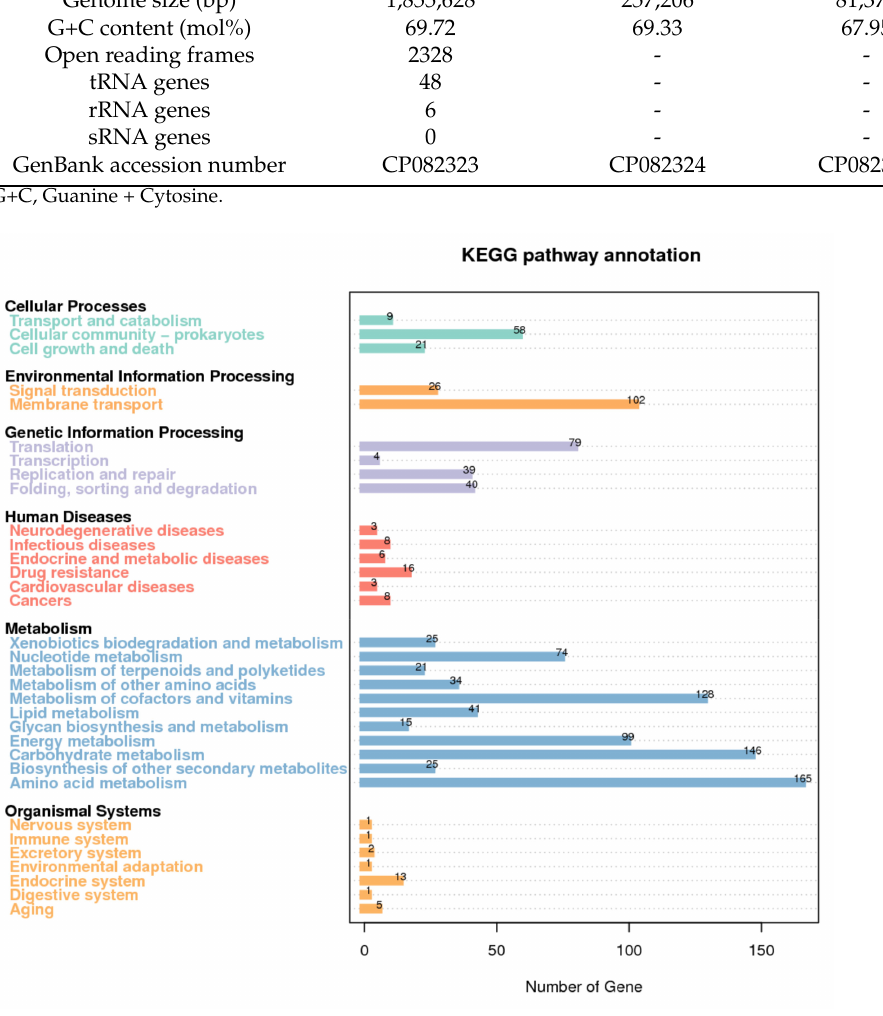
Figure 3. KEGG annotation of T. thermophilus N-1 based on pathway type and gene